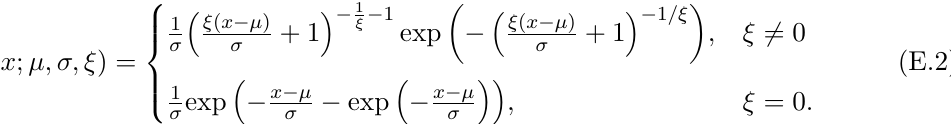
JHEP06(2021)061